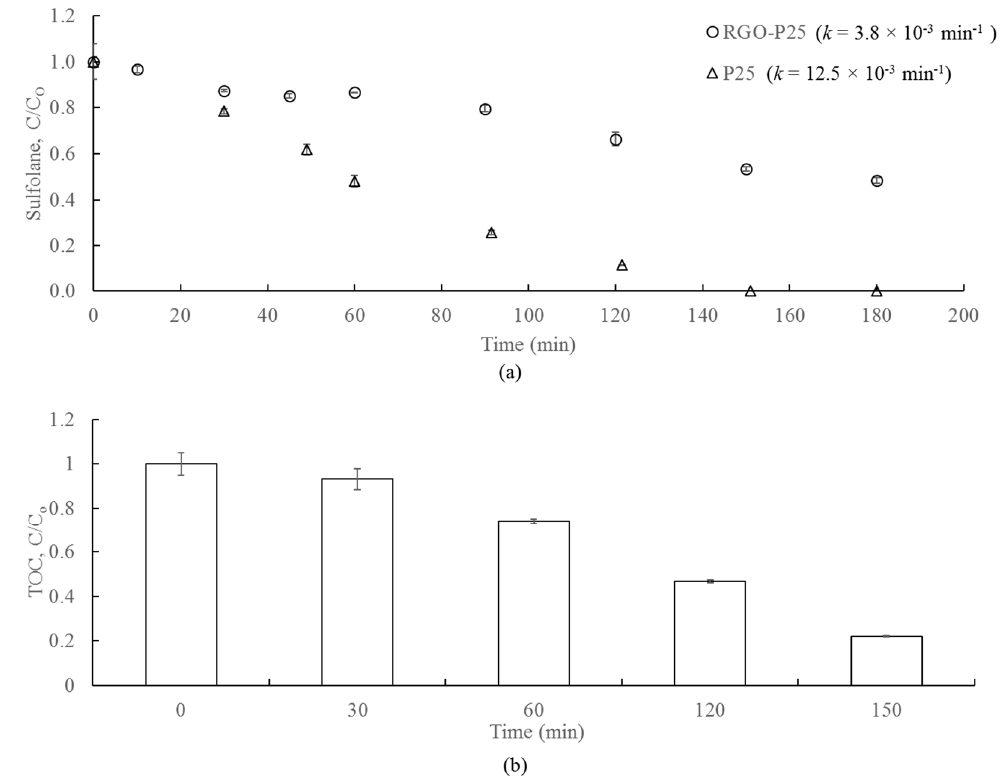
Figure 1. ( a ) Adsorption and photocatalytic degradation of sulfolane using P25 and RGO-P25, ( b ) the change of TOC concentrations during photocatalytic degradation of sulfolane by P25.